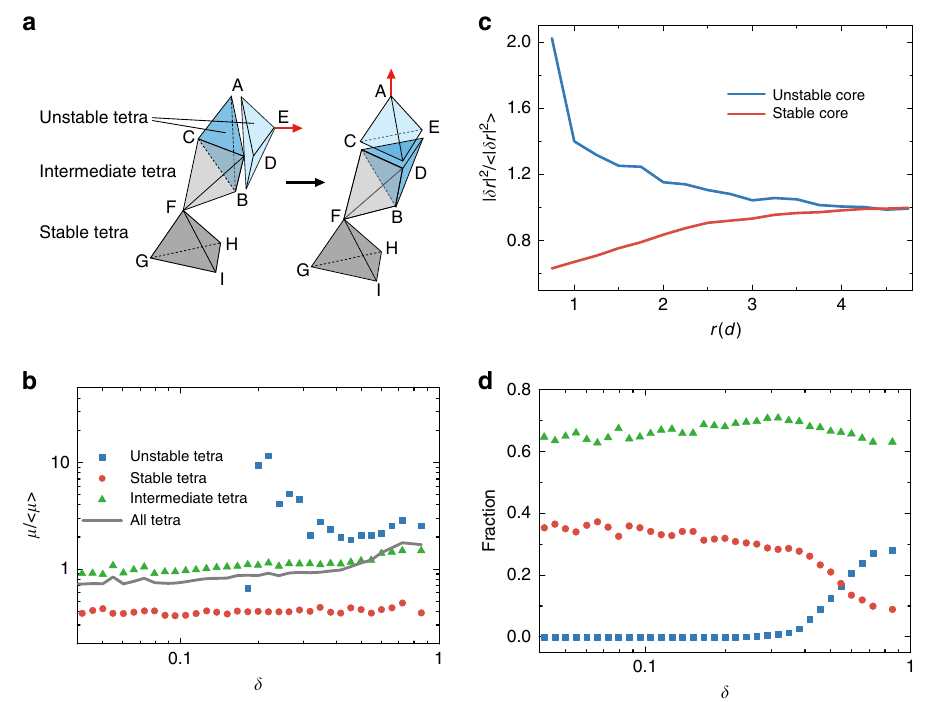
Fig. 3 Tetrahedral species and their plastic properties. a Schematic of spatial relationship of the three types of tetrahedra. b Correlation between non-af fi ne mobility μ and shape parameter δ for three types of tetrahedra. c Normalized square non-af fi ne displacements of particles vs. distance r from the unstable and stable cores. The unstable cores are geometrical centers of unstable tetrahedra. The stable cores are geometrical centers of stable tetrahedra. d Fraction of three types of tetrahedra as a function of the shape parameter